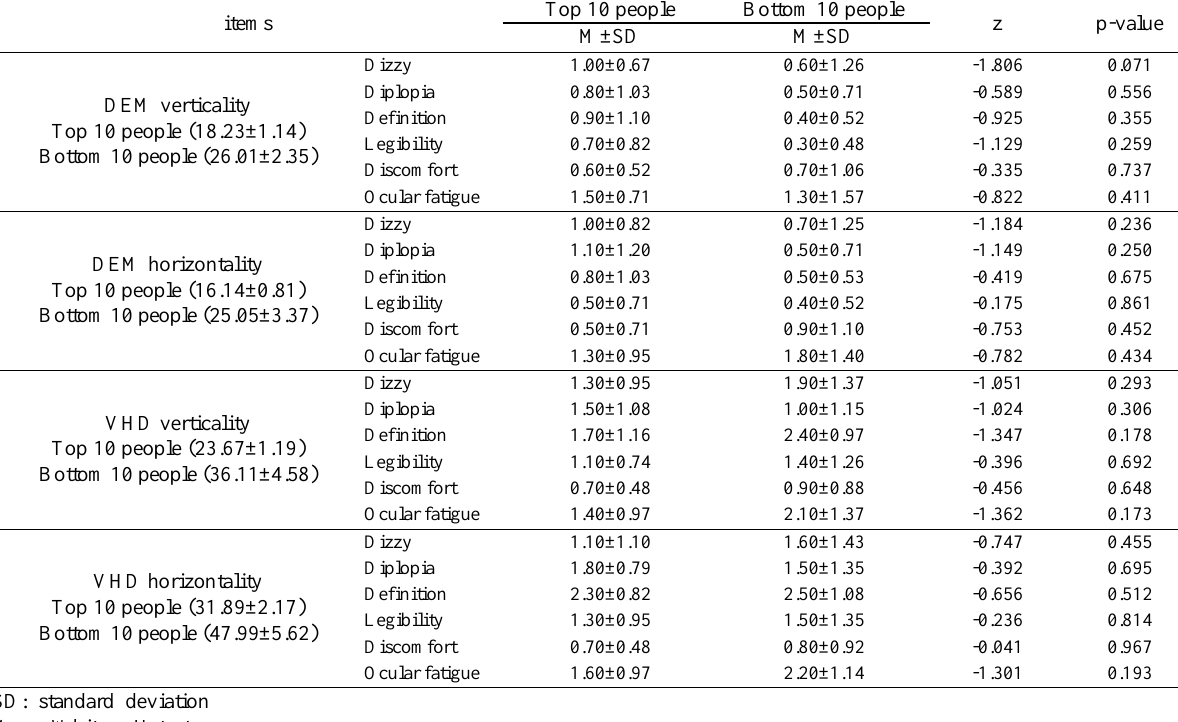
Top 10 people Bottom 10 people M±SD M±SD